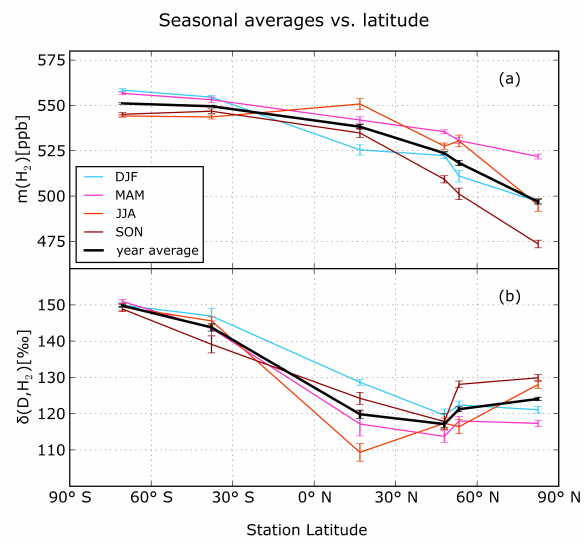
Fig. 4. Seasonal averages and seasonally weighted yearly averages of m (H 2 ) (a) and δ D (b)